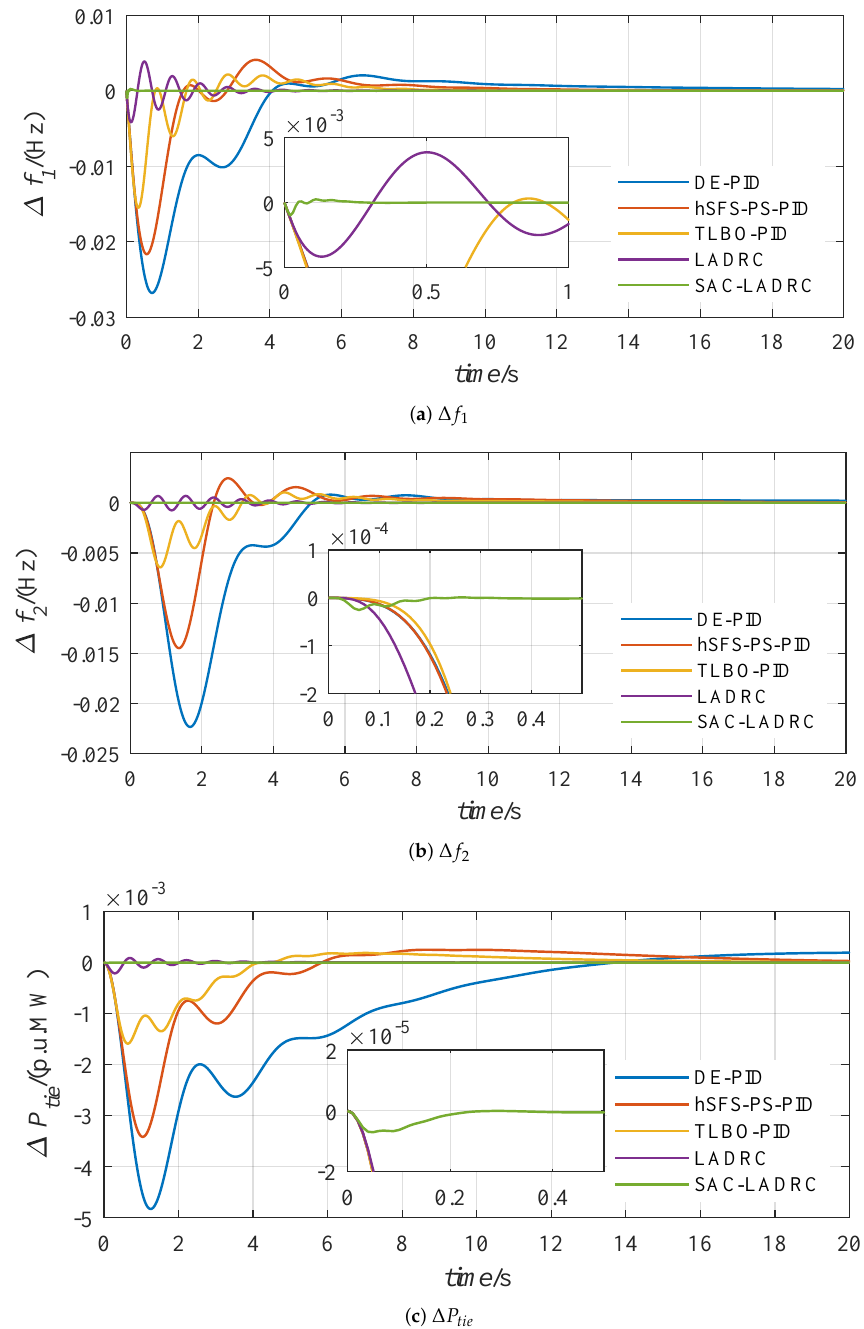
Figure 6. Dynamic response comparison